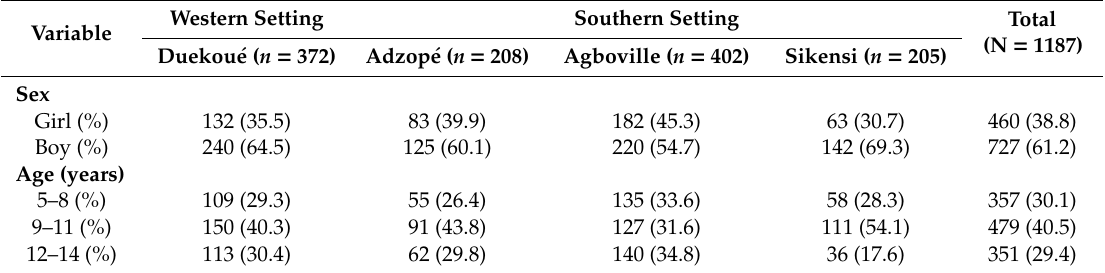
Table 1. Sociodemographic characteristics of the study population subjected to schistosomiasis diagnosis in di ff erent settings of C ô te d’Ivoire in early 2018.